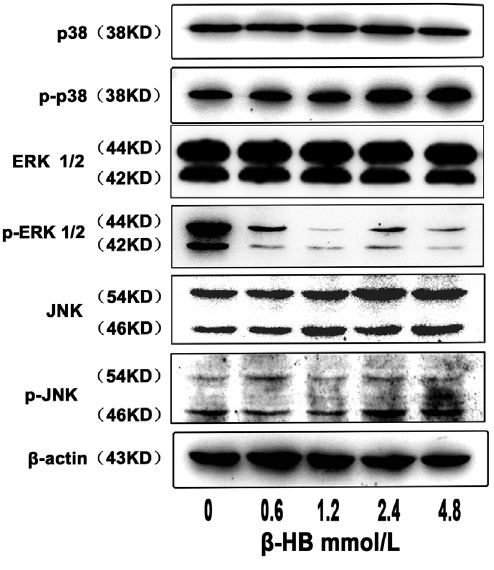
Figure 3. Effect of b -HB on phosphorylation of MAPKs in BSMCs. Cells were incubated 48 h with b -HB (0, 0.6, 1.2, 2.4 or 4.8 mM) in serum-free medium. Phosphorylated-p38 and total p38, phosphor- ylated-JNK and total JNK, phosphorylated-ERK1/2 and total ERK1/2 were detected by Western blot.